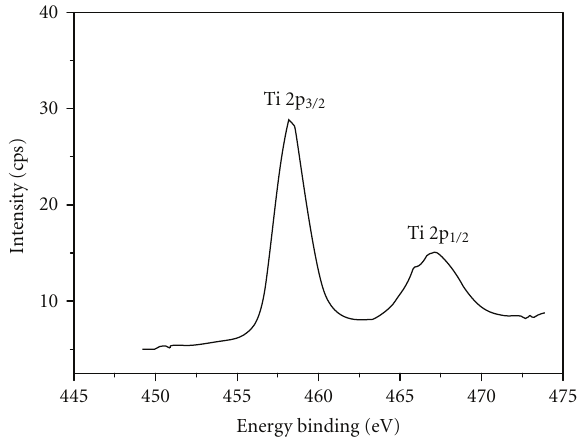
Figure 6: Ti 2p XPS spectrum for the oxide film potentiodynami- cally grown on the dental implant, Ti-grade 2, in PBS